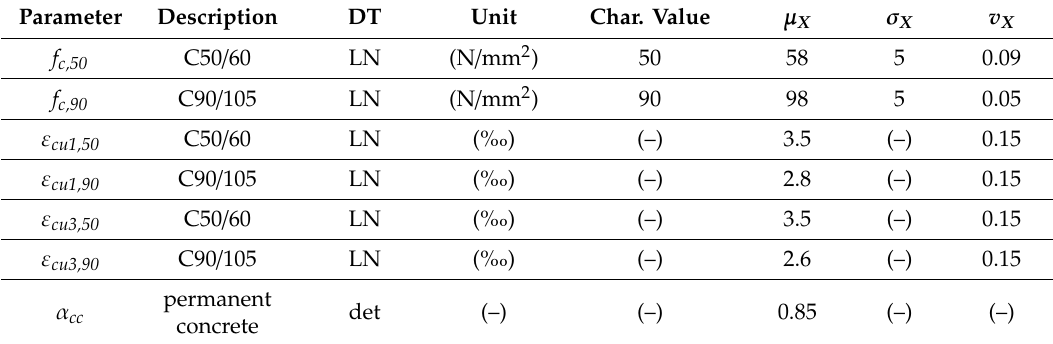
Table 5. Overview of the concrete properties—description of the stochastic model for the basic variables.